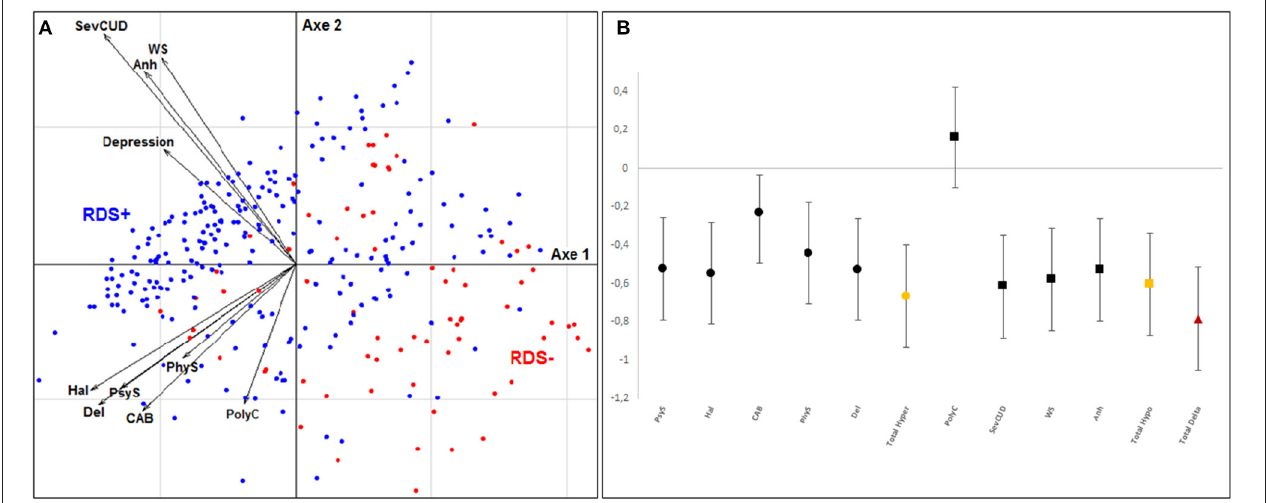
FIGURE 3 | Multidimensional factor analysis and effect size for global model. (A) Tridimensional representation of the distribution of subjects with and without depressive symptoms during cocaine withdrawal (RDS– group in Red, RDS + group in Blue) according to clinical variables of global dopaminergic model: severity of dependence (SevCUD), withdrawal symptoms (WS), anhedonia (Anh), polyconsumption (PolyC), psychotic symptoms (PsyS), hallucinations (Hal), delusions (Del), consumption-associated behavior (CAB), physical symptoms before use (PhyS); and direction of variables. (B) Hedges’ effect-size of each variable for the global dopaminergic model